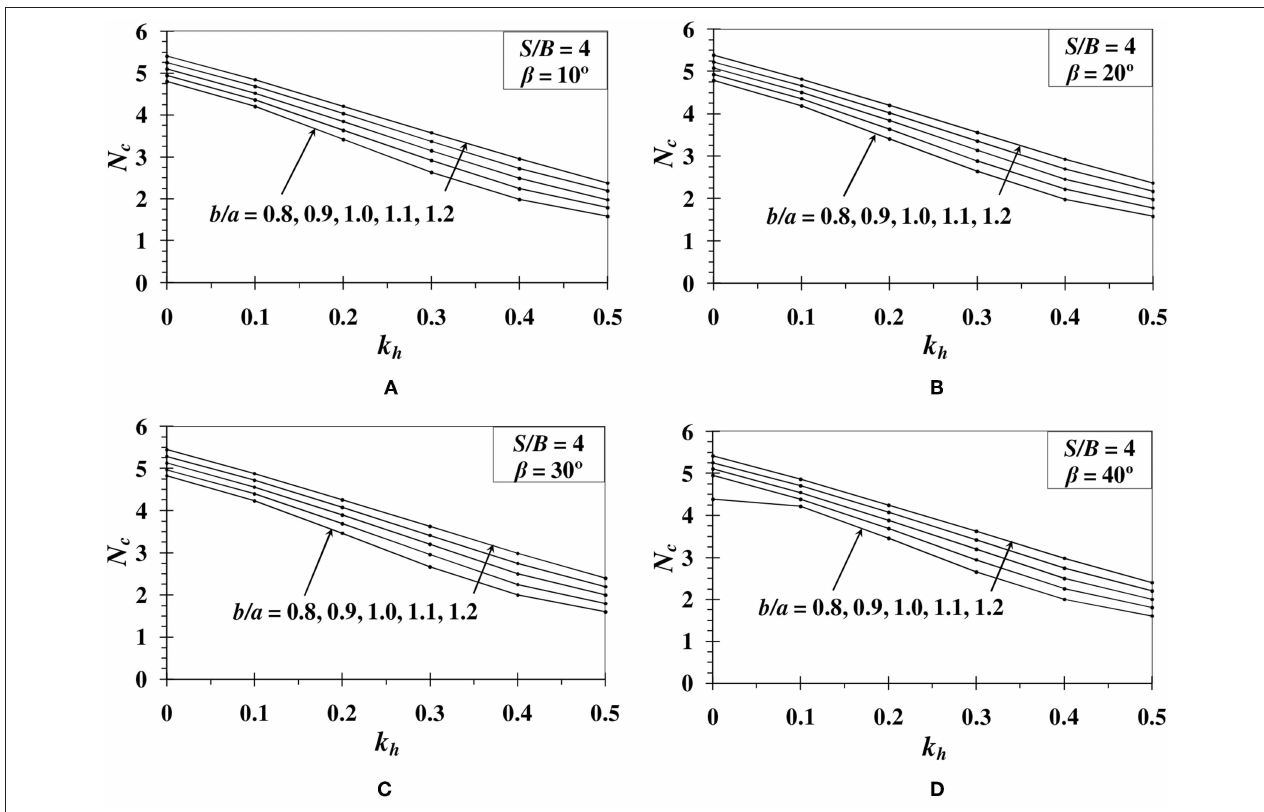
FIGURE 4 | Variation of N c with respect to k h for S/B